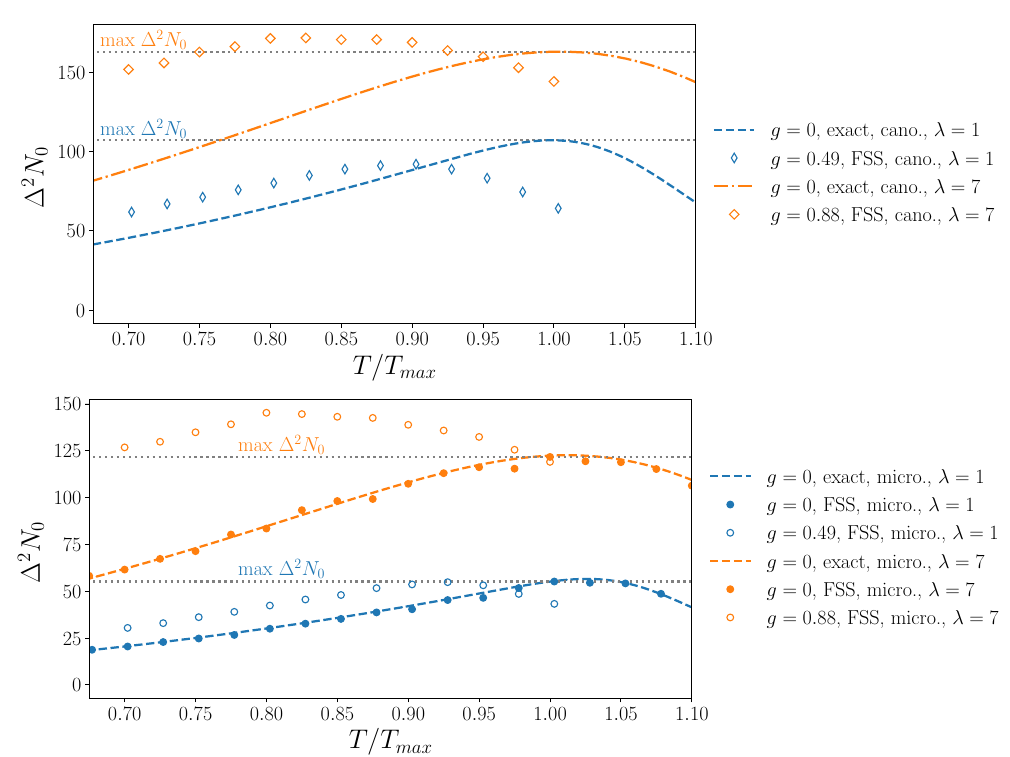
Figure 9: Atom number fluctuations with and without interactions in a 3D harmon- ically trapped gas containing N = 100 atoms, computed in the canonical (top) and microcanonical (bottom) ensemble. The variance of the atom number is shown as a function of temperature for a spherically symmetric λ = 1, (blue) and an elon- gated λ = 7 (orange) trap with and without interactions. The horizontal dashed lines correspond to the maximal condensate atom number fluctuations for the non- interacting gas in each case. The reference temperature T is the temperature of max maximal fluctuations of the non-interacting gas in the canonical ensemble. The units (cid:112) ) 3 ω / ħ h of the interaction strength g are ( m ω 2 ⊥ z